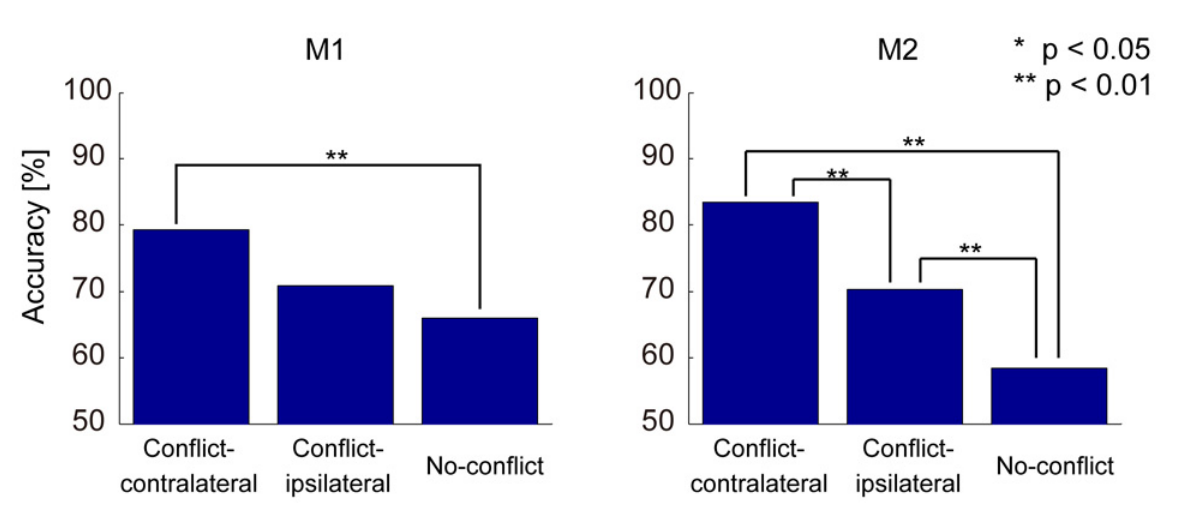
Fig 6. Accuracy of the full-set neural classifier. The bar graphs indicate accuracy of the full-set neural classifier in the conflict – contralateral, conflict – ipsilateral, and no-conflict conditions for monkeys M1 and M2. The classifiers were computed by using the full set of ECoG spectrum data during the period from 3000 ms prior to 375 ms after the start of the food-presentation period. We tested the differences (accuracy/chance level) between each condition to ignore the differences in chance levels for the neural classifier in each condition. In this result, there were significant differences in accuracy between the conflict – contralateral condition and the no-conflict condition in M1 and M2 (M1, Z = 2.713, p < 0.01; M2, Z = 7.115, p < 0.01) and between the conflict – contralateral condition and the conflict – ipsilateral condition in M2 (Z = 2.764, p < 0.01).